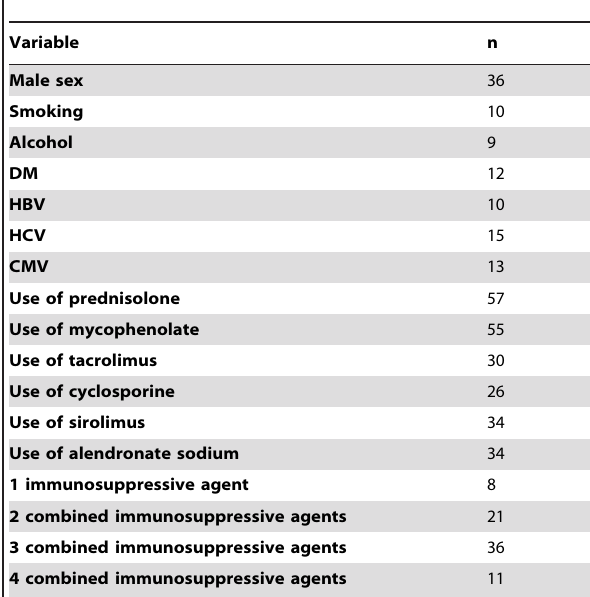
Table 1. Baseline characteristics of 76 patients.